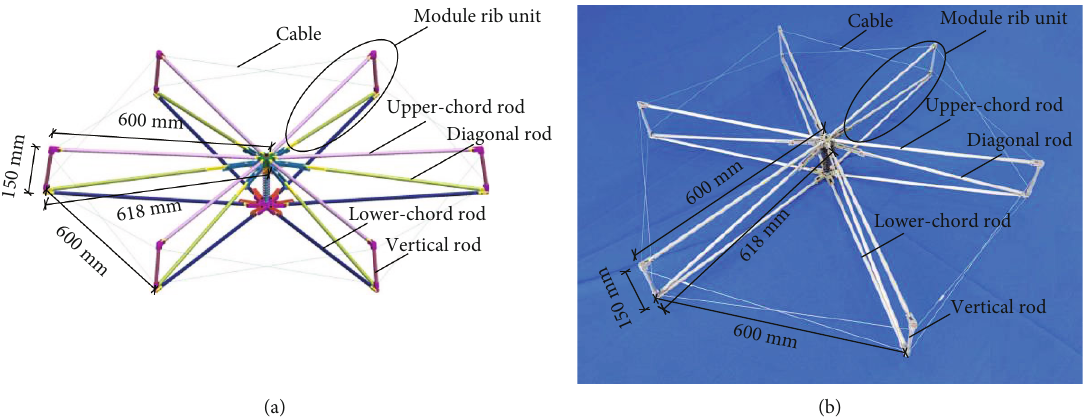
Figure 1: A single module. (a) The three-dimensional prototype. (b) The single-module prototype.